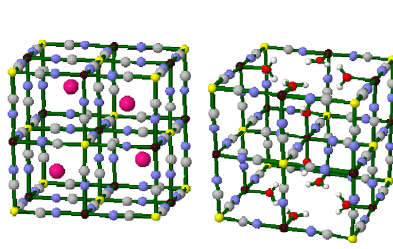
( a ) Prussian Blue NPs on gold electrode. ( b ) Structures of soluble (left) and insoluble (right) Prussian blue Nanoparticles. Figure 2. Characteristics of Prussian blue nanoparticles (PBNPs). ( a ) SEM micrograph of the PBNPs deposited by drop casting over an electrode; ( b ) Prussian blue crystalline structure. With permission from